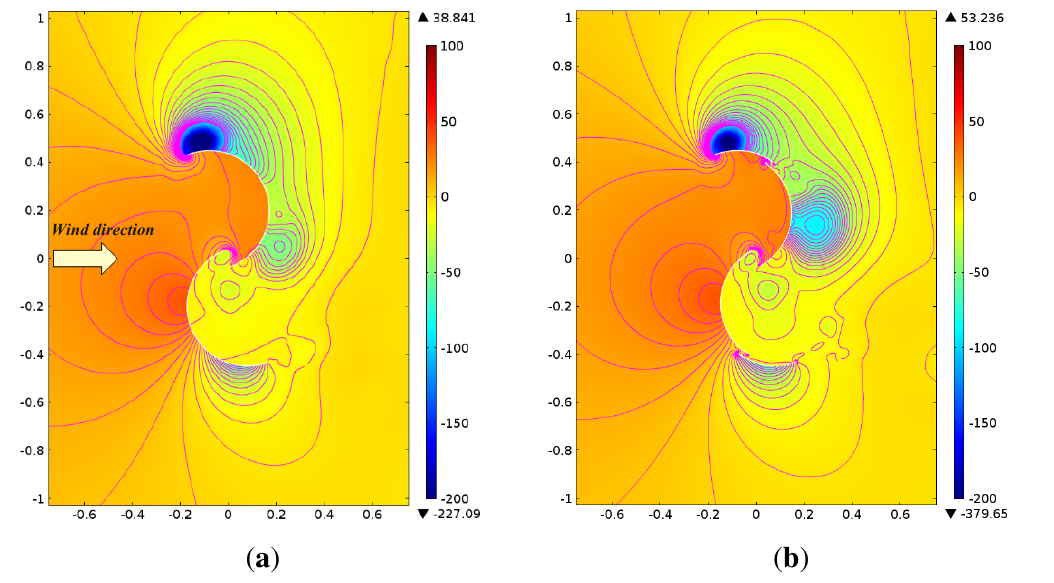
Figure 12. Velocity vector contours for the standard ( a ) and f = 75% ; ( b ) analyzed at λ = 1